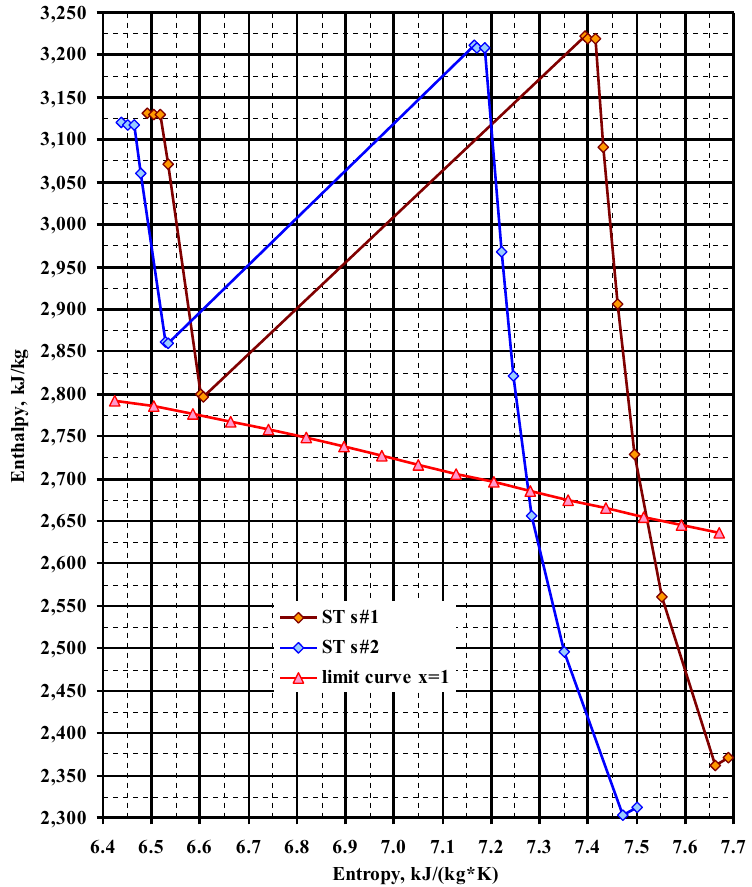
Fig. 5. The enthalpy-entropy diagram for the processes in the ST, in the two